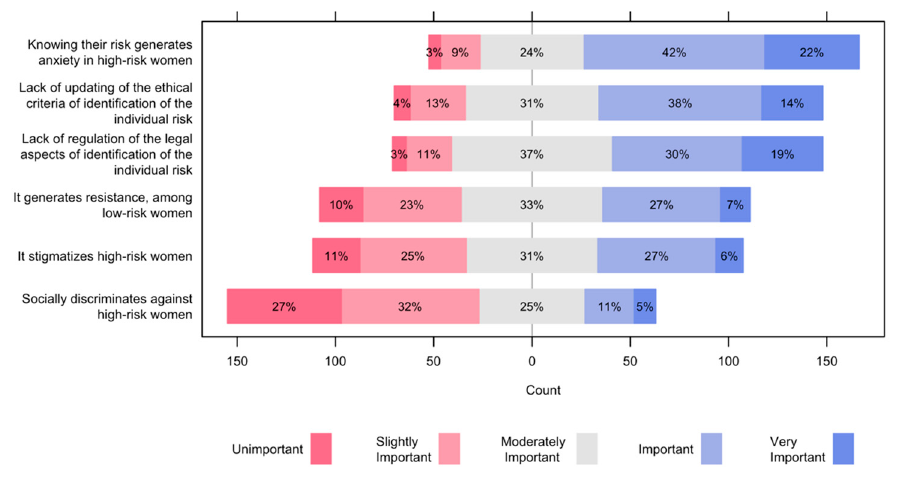
Figure 2. Disadvantages of risk-based screening for women’s health.